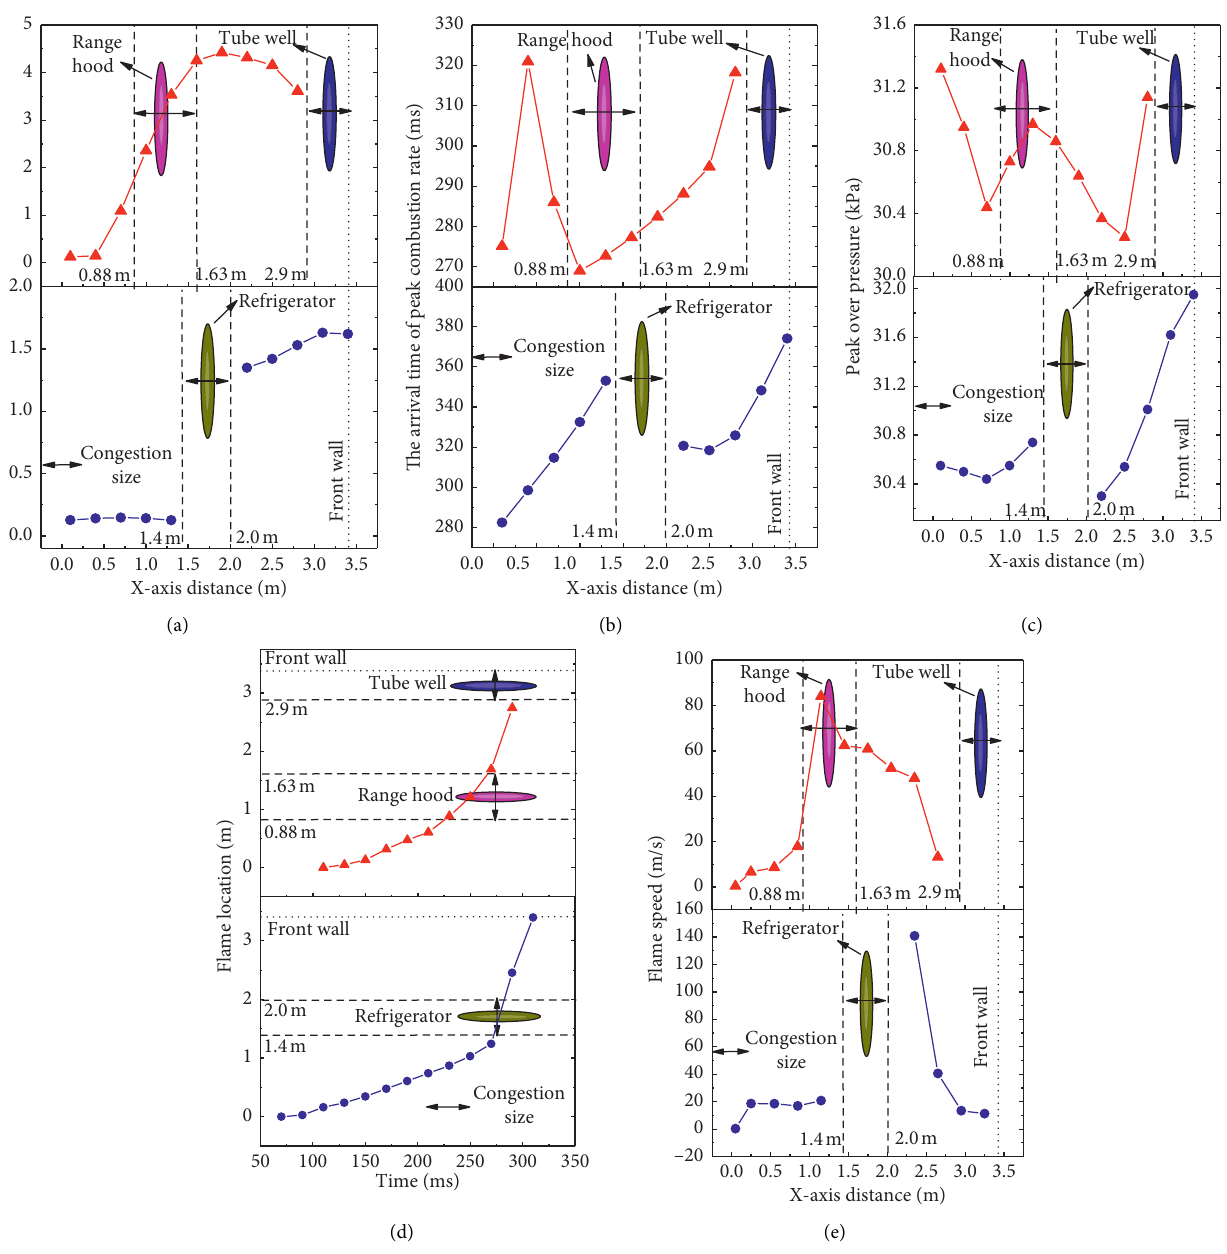
Figure 11: The variation law of (a) peak combustion rate and (b) arrival time, (c) overpressure time curve, (d) time trajectory of flame front position, and (e) flame speed of paths y � 1.8 m (down) and y � 0.3m